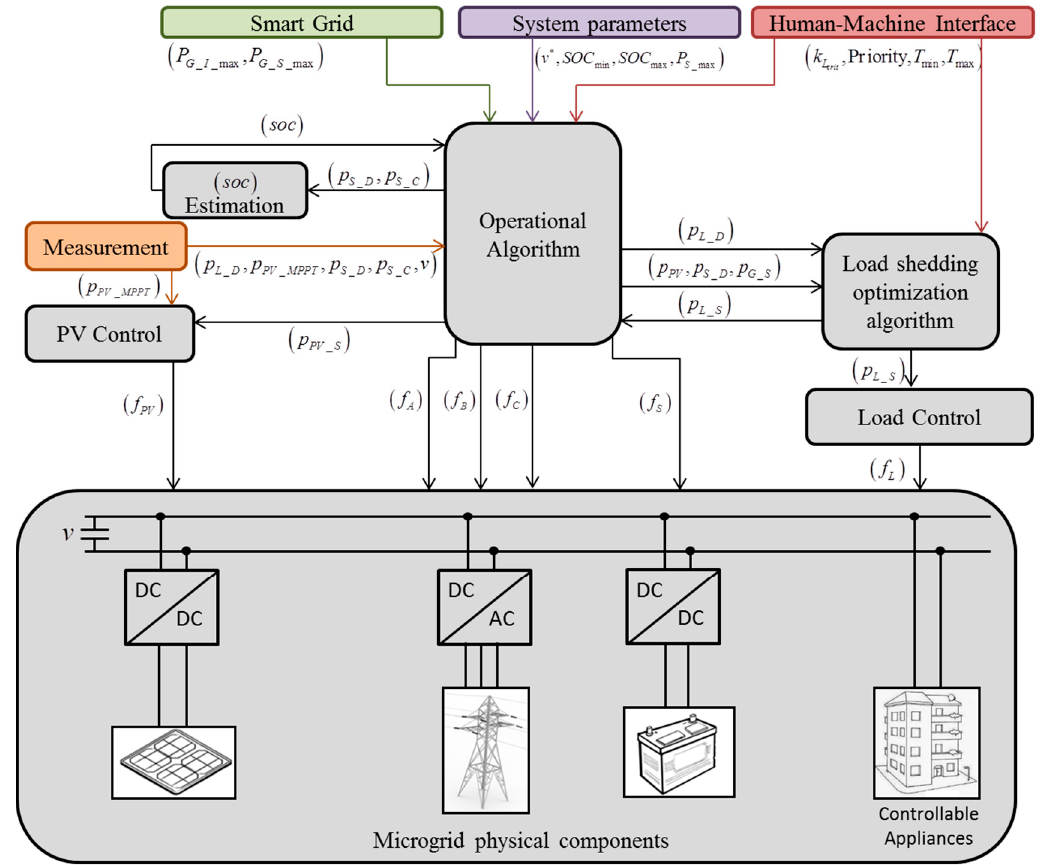
Figure 3. Supervisory and power control structure.